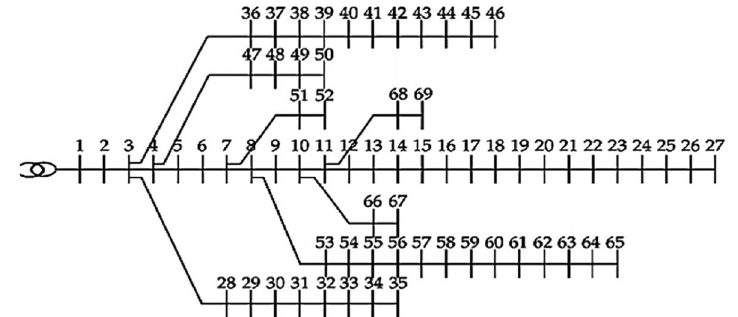
Fig. 4 IEEE 69-bus distribution